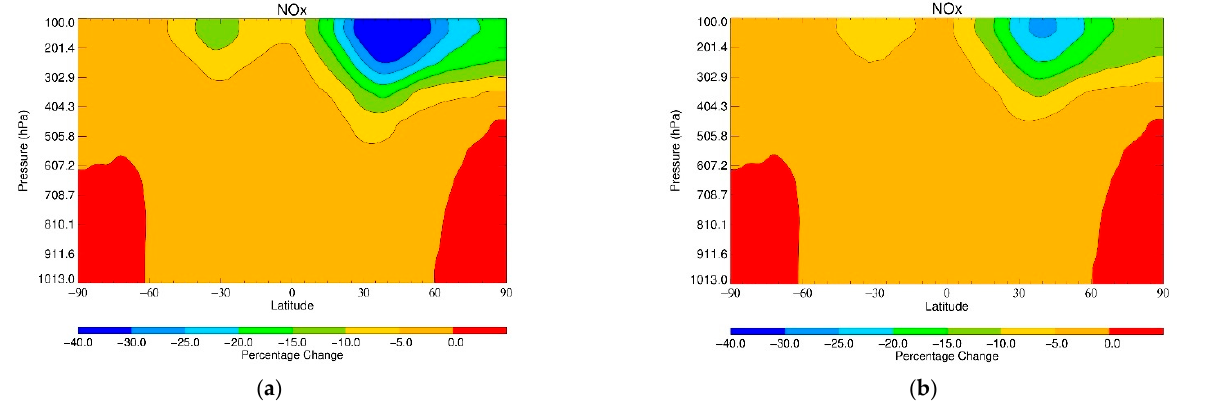
Figure 2. The percentage zonal change of NO x mixing ratios from ( a ) STOCHEM-base to STOCHEM-75NO x scenario, ( b ) STOCHEM-base to STOCHEM-50NO x scenario. Note: The approximate height equivalent to the pressure in the y -axis can be found in Appendix A (Table A1).